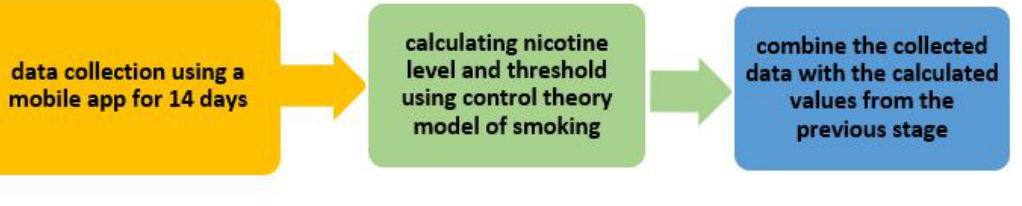
Figure 4. Overview of the study: data collection and processing